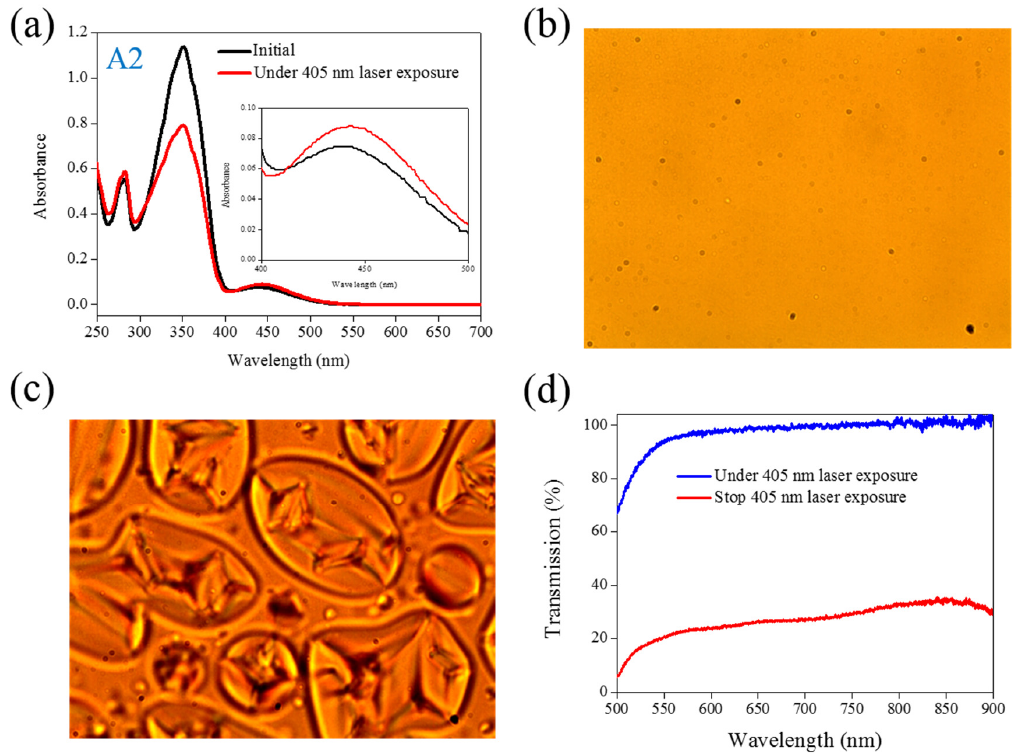
Figure 2. ( a ) Absorption spectral response of A2 of M 5 101   in the THF solution